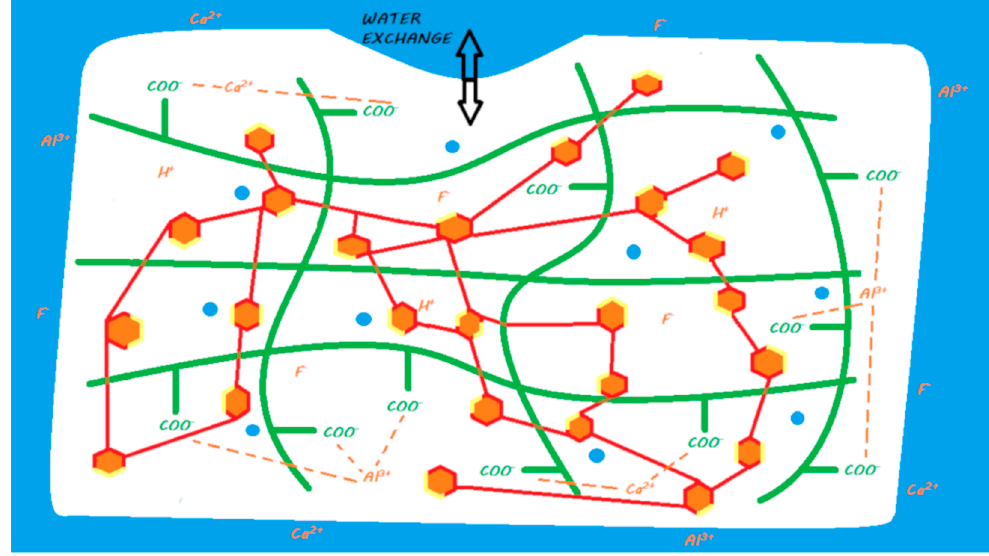
Figure 7. Ion release from an RM-GIC once it is in a moist environment (i.e., an oral environment). When the powder and liquid are mixed, the acid–base reaction is initiated, the setting of the material begins, and the FAS fillers are partially attacked: a silicic gel is partially formed on the FAS filler surface. The released calcium and aluminum ions are able to form ionic bonds with ionized carboxylic groups. Fluoride ions are also released. A second reaction of resin polymerization is activated when the material is light-cured: monomers can copolymerize with other monomers or silanated FAS fillers. At the end of the reaction, two different interpenetrated networks are produced without covalent or ionic links between both. In water, calcium, aluminum, and fluoride ions (and eventually other ions) are able to be exchanged with the oral environment.